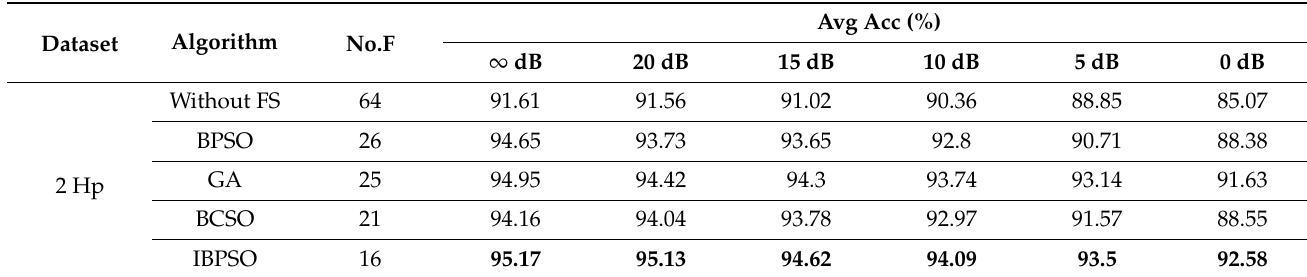
Table 15. Classification results using FCNN-E.